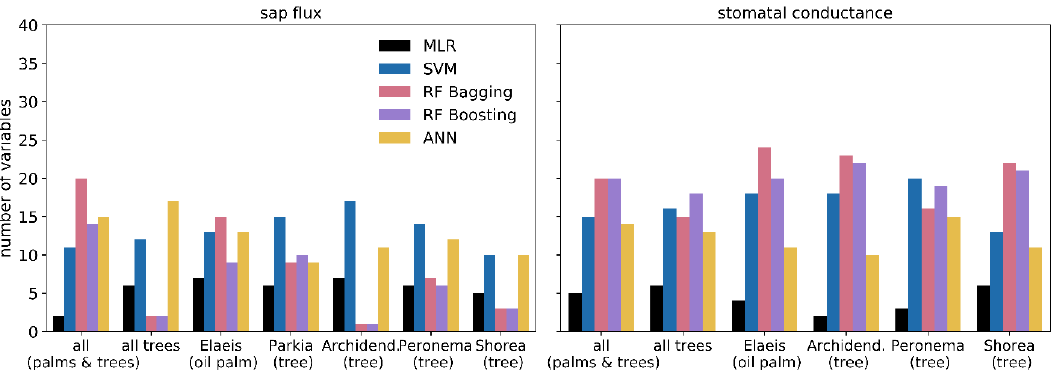
Figure 8. Number of most important input variables that explain 95% of the corresponding model.